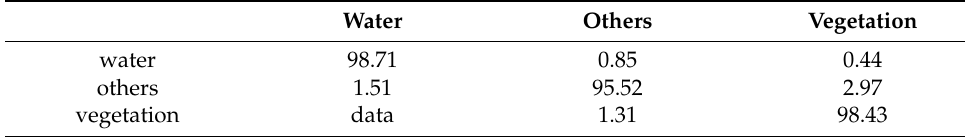
Table 1. Confusion matrix of FCN-8s (unit: